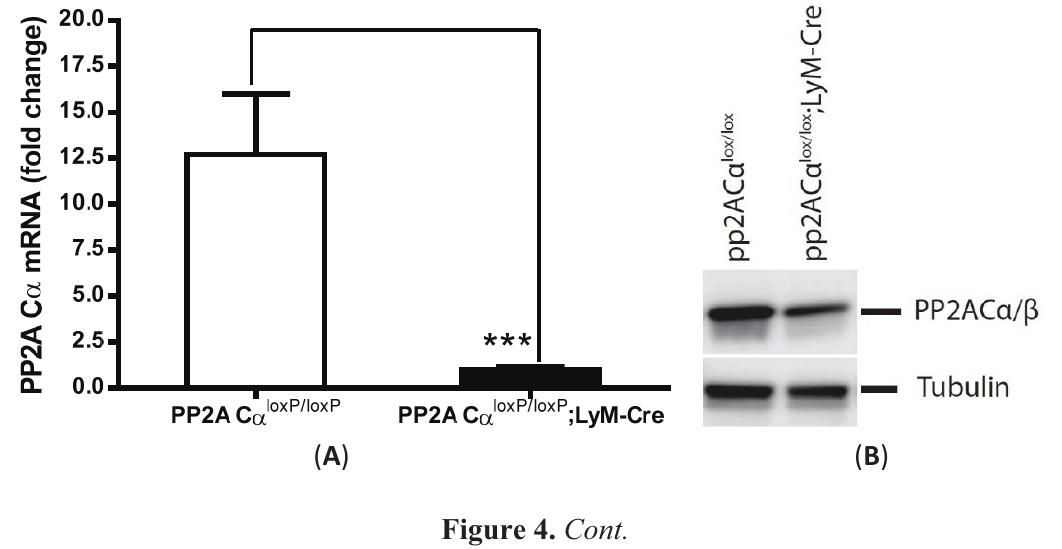
Figure 3. Immunoprecipitation-aided fluorescence method of measuring PP2A activity in tolerized peritoneal macrophages. Anti-PP2A IgG was incubated with Protein A/G magnetic beads for 30 min and then cross-linked to the beads by DSS. Cell lysates were then incubated with antibody-conjugated beads for 1 hr at room temperature and the beads were removed of were washed to remove non-specific binding. Assay buffer containing DiFMUP and NiCl 2 was added to the beads, mixed and incubated at room temperature for 30 min. Supernatant removed of beads was measured on a SpectraMax M3 plate reader. ( A ) Anti-PP2A dose-response. Three doses of anti-PP2A IgG were cross-linked to the beads and incubated with the same amount of input lysates (75 μg) for the phosphatase assay; ( B ) Flow through section after beads were removed was examined for the presence of PP2A to determine pulldown efficiency; ( C ) Input cell lysates dose-response. Same amount of anti-PP2A IgG (2.5 μg) was incubated with two doses of cell lysates (75 μg and 150 μg). PP2A activity was measured by DiFMU method. Y axis shows the absolute values of DiFMU in solutions; ( D ) LPS tolerance induced upregulated PP2A-activity in peritoneal macrophages. 75 μg of cell lysates harvested from naïve or tolerant peritoneal macrophages were subjected to immunoprecipitation with 2.5 μg of anti-PP2AC antibody. Y-axis shows the absolute values of